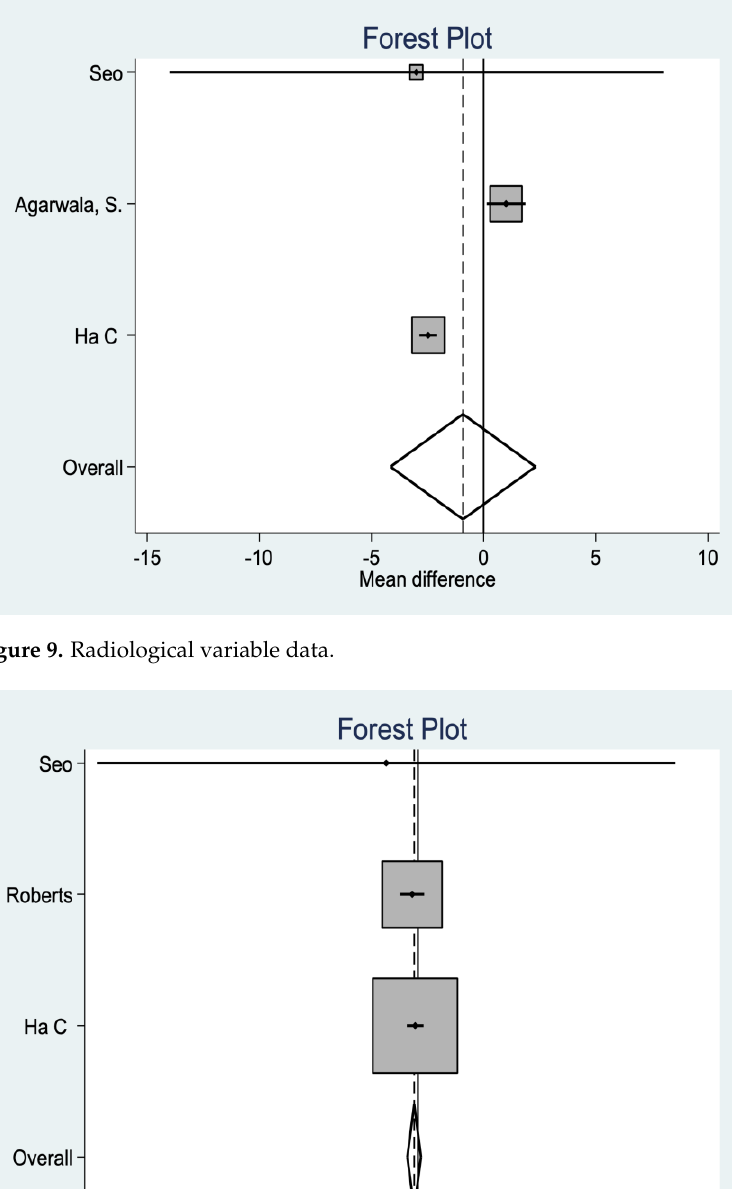
Figure 10. Radiological variable Figure 10 Radiological variable data.